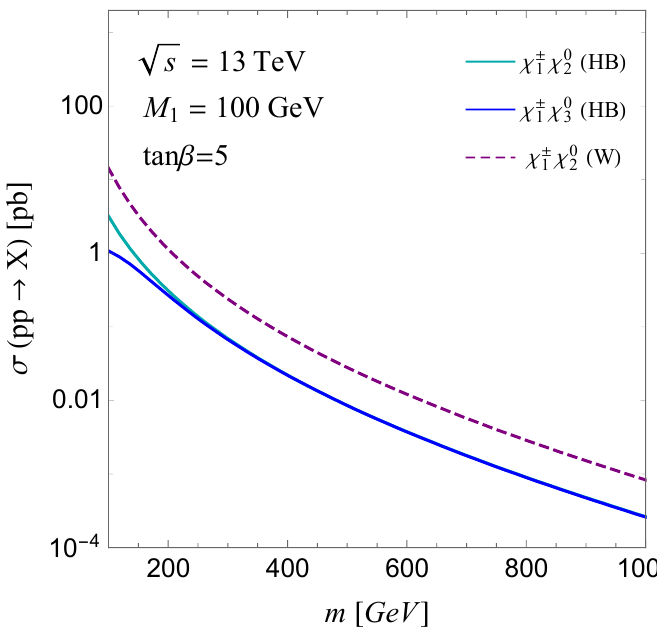
Figure 2 . Comparison of the LO direct production cross sections of electroweakinos in the pure Wino scenario (dashed lines) and the Bino-Higgsino scenario (solid lines) with M 1 = 100 GeV and tan (cid:12) = 5, assuming that scalar superpartners are decoupled. In the former case, (cid:22) = m = M 2 is varied. In the latter, M 2 = 2 TeV and m =